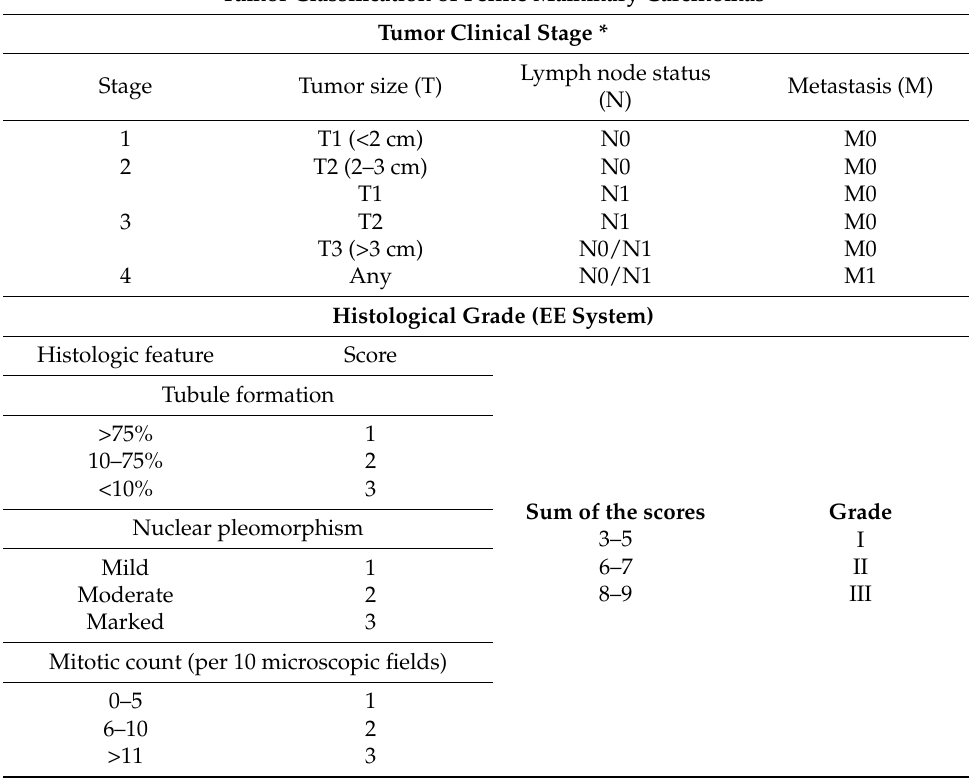
Table 1. Tumor clinical stage and histological grade for feline mammary carcinoma. (Adapted from the System modified from Owen LN., Classification of tumors in domestic animals, Geneva World Health Organization, 1980; and Elston & Ellis Grading System, 1998,